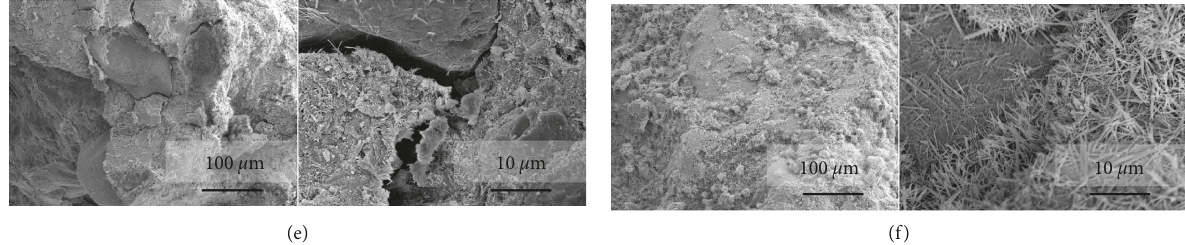
Figure 11: Micrographs of the mortar sample. Sectional microstructure of the baseline sample at the (a) 12 th and (b) 36 th FTCs. Sectional microstructure of the hydrophobic sample at the (c) 12 th , (d) 36 th , and (e) 72 nd FTCs. (f) Microstructure of the hydrophobic coating on the hydrophobic sample at the 72 nd FTC.